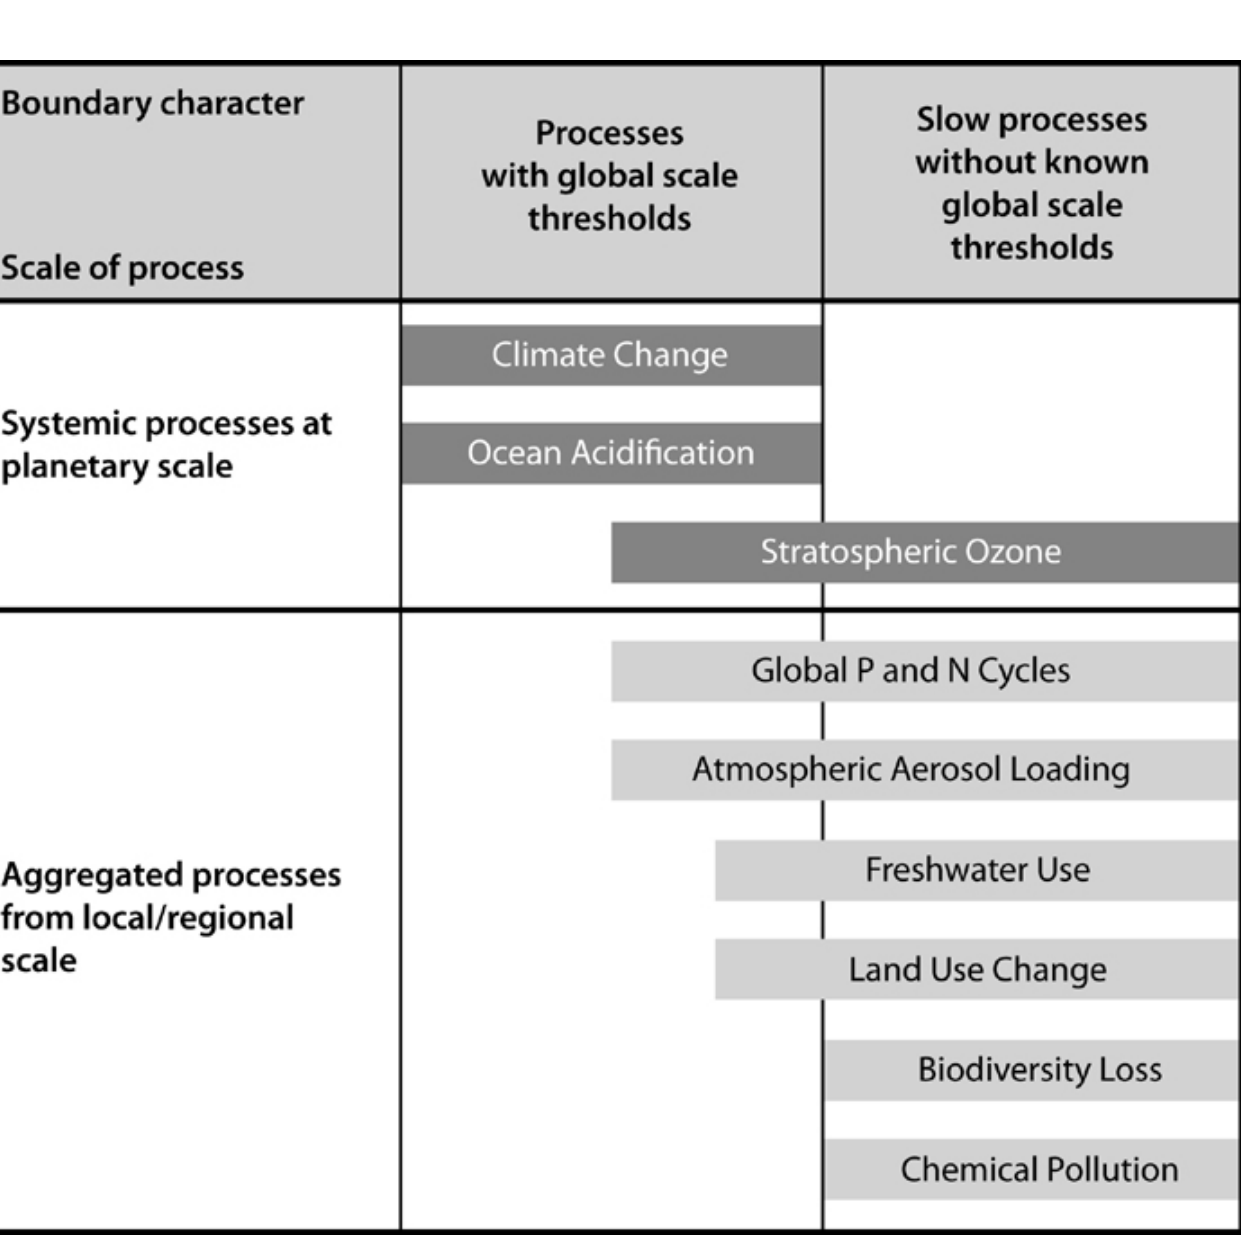
Fig. 4. Categories of planetary